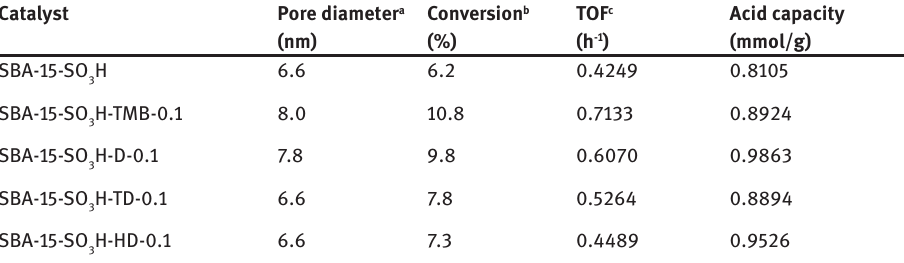
Table 3: Comparison of non-swelled SBA-15-SO